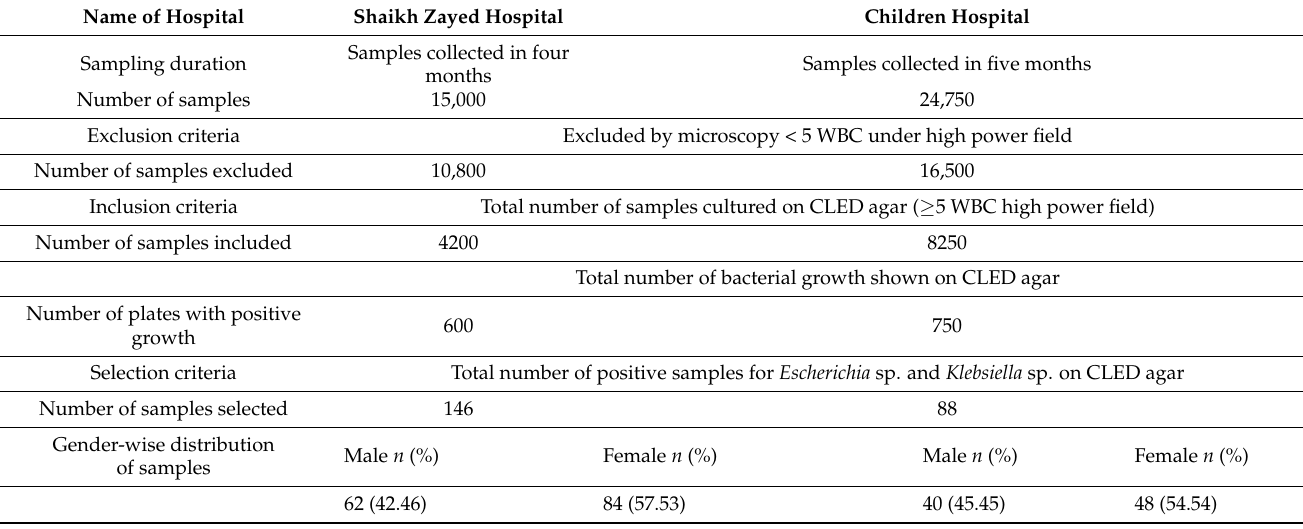
Table 1. Total number of samples of pediatric patients (aged 0–6 years) from Shaikh Zayed and Children Hospital, Lahore,